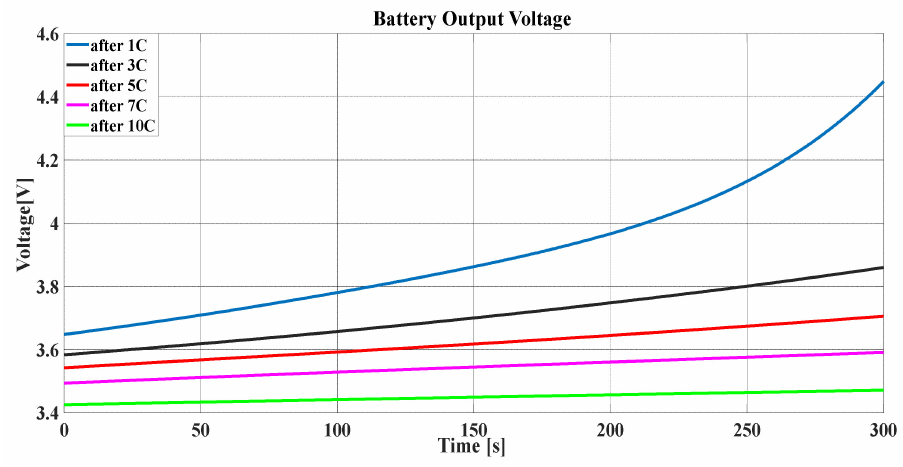
Figure 17. The di ff erent voltage performances after charging based on the